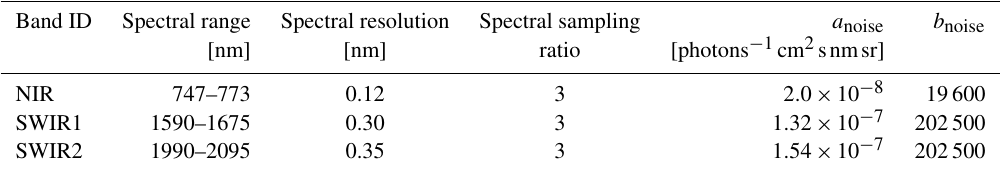
Table 1. Setup of the CO2M